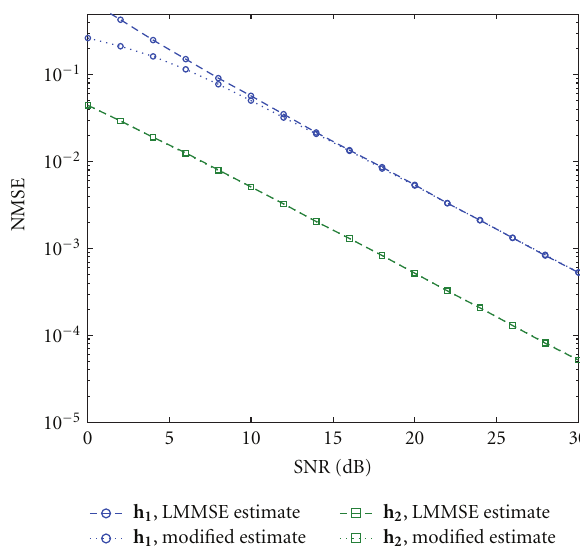
Figure 6: Channel estimation NMSEs versus SNR for α = 0.7071.